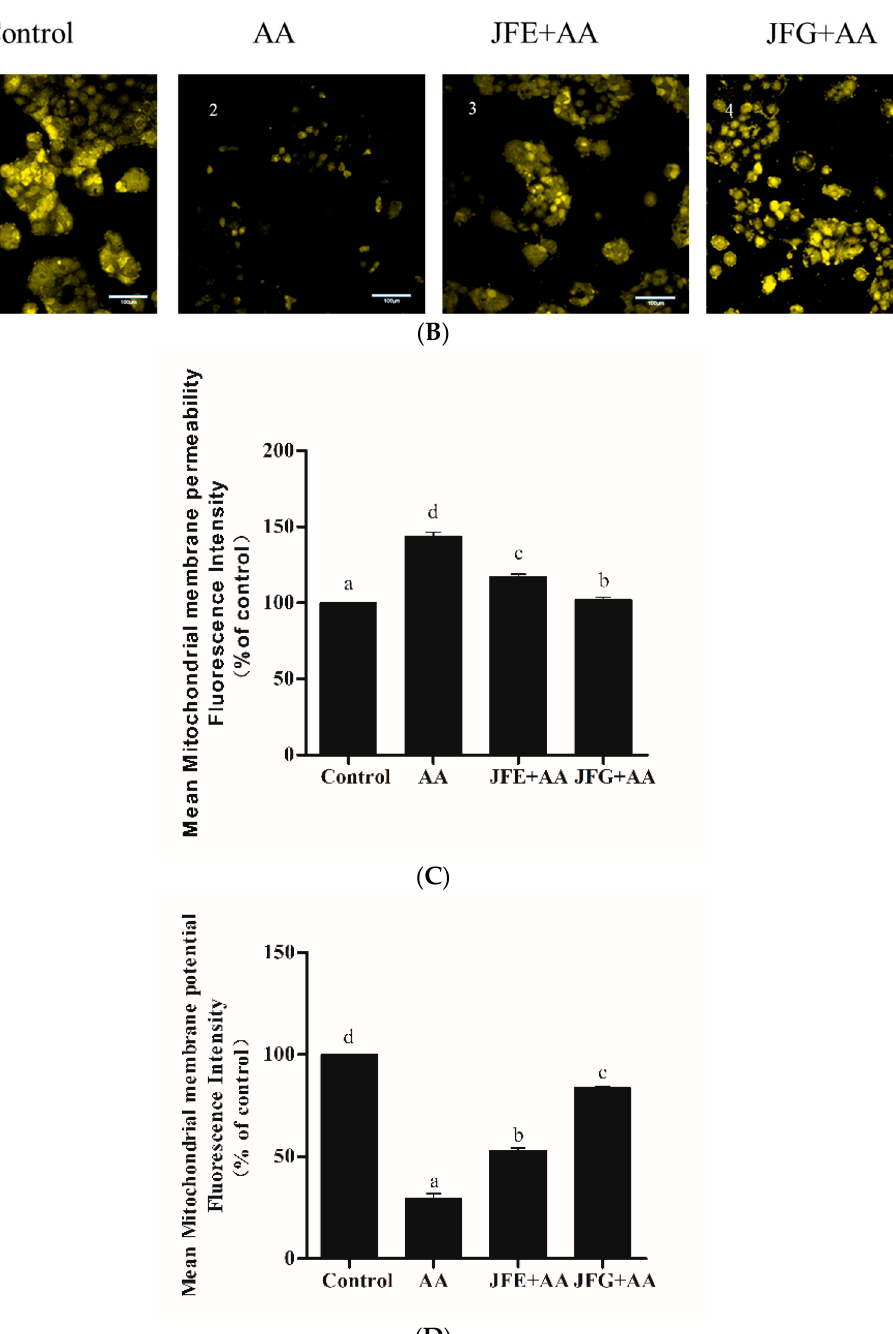
Figure 4. Effects of JFE and JFG on AA-induced Caco-2 mitochondrial permeability and mitochondrial membrane potential. ( A , B ) Caco-2 cells were treated with 2 g/L AA for 2 h, with or without 2 mg/mL JFE or JFG for 24 h, and photographed using HCA. Scale bars = 100 μm . ( C , D ) The mean mitochondrial permeability and mitochondrial membrane potential fluorescence intensity of AA groups, JFE groups, and JFG groups were determined by Image-IT ® DEAD Green TM viability stain, and the control groups were set to 100%. The data was expressed as mean percent (mean ± standard deviations), and di ff erent letters in the bars within each group represent statistically significant di ff erences ( p < 0.05).